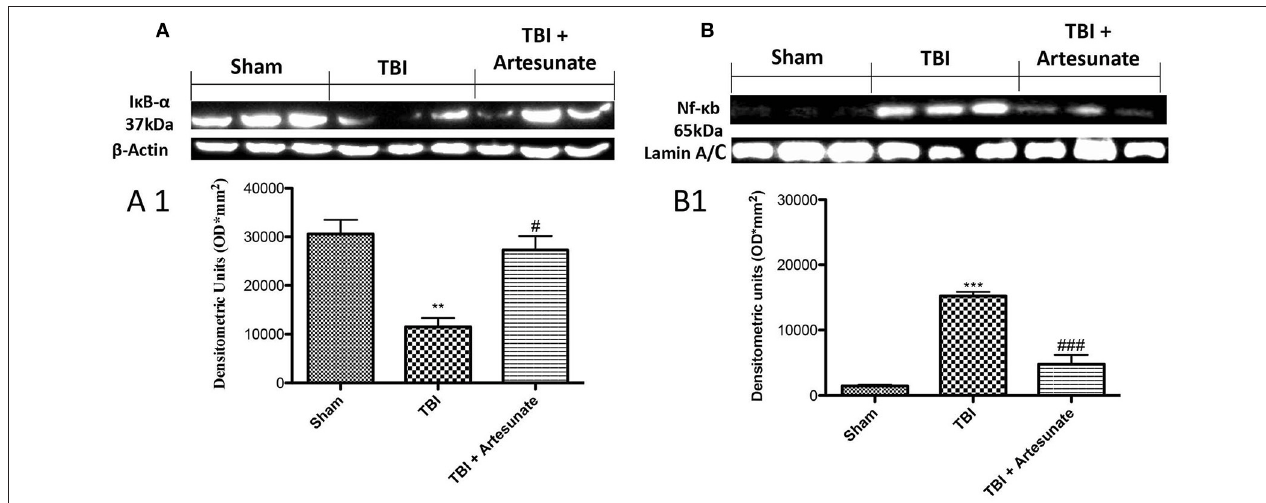
FIGURE 2 | Protective effect of artesunate treatment on I κ b- α degradation and Nf- κ b translocation. (A) Show the basal expression of I κ B- α in brain homogenates from sham group, 24h after TBI injury there is a significant reduction in I κ B- α expression, while the treatment with artesunate was able to prevent reduction in I κ B- α expression, see densitometric analysis (A1) . (B) Showed a significantly increase in Nf- κ b expression 24h after TBI injury, in vehicle group. When compared with vehicle group, treatment with artesunate 30 mg \ Kg significantly reduce the Nf- κ b expression see densitometric analysis (B1) . Data are expressed as Mean ± SEM from N = 10 Mice for each group. ** P < 0.01 vs. respective sham; *** P < 0.001 vs. corresponding sham group. # P < 0.05 vs. corresponding TBI. ### P < 0.001 vs. corresponding TBI. ( F -value for I κ B- α = 17.23. df = 2. r 2 = 0.8733) ( F -value for Nf- κ b = 63.74. df = 2. r 2 = 0.9550) (see the Supplementary Figures 1, 2 for the triplicate of western